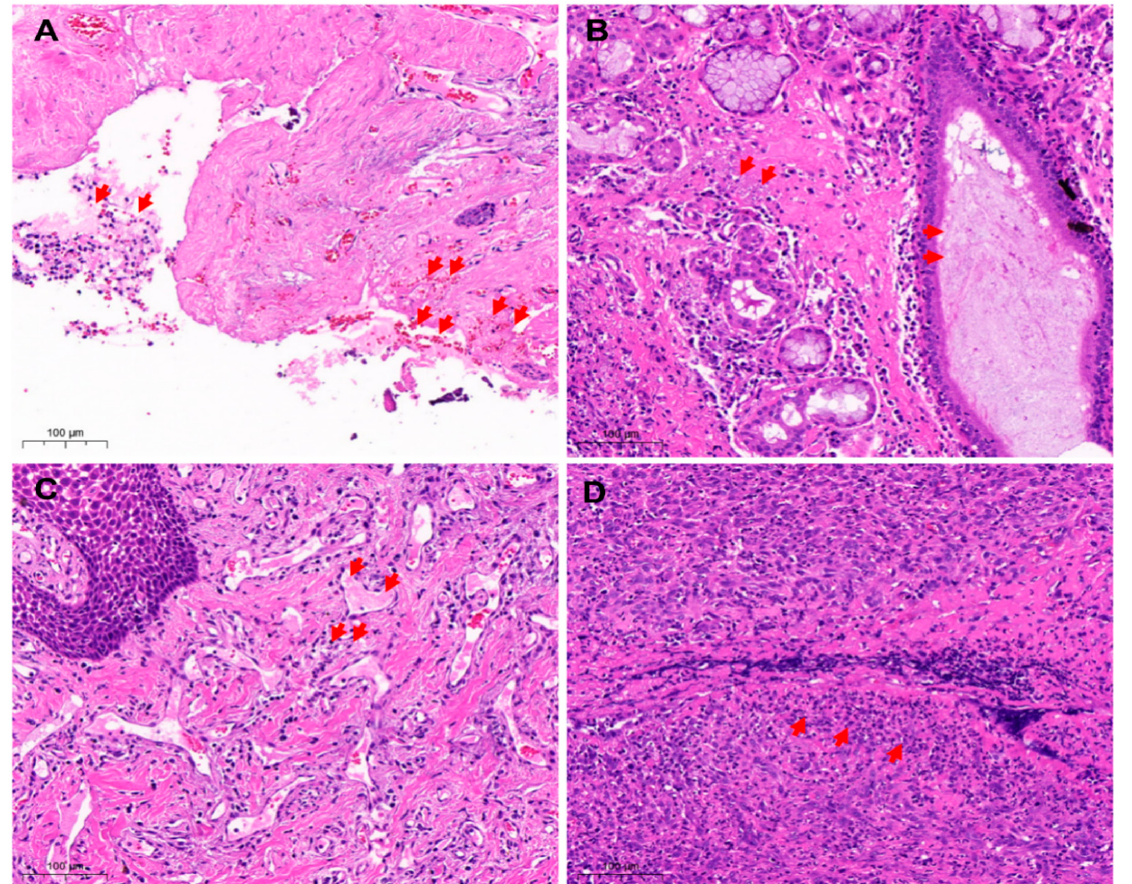
Figure 3. Histopathological analysis of oropharyngeal samples. ( A ) Loss of oral mucosa (H&E 20x). The gingival mucosa epithelial cells fell off, and the lamina propria was congested and hemorrhaged with many inflammatory cells that targeted endothelial cells (arrows) and contributed to the developmental abnormalities of structure and function. ( B ) The mucosal epithelial cells were necrotic and exfoliated (H&E 20×). The inflammatory cells were extensively infiltrated and necrotic. The acinar epithelial cells degenerated, filling the acinar cavity with mucus (arrows). ( C ) Necrosis of cells in the lamina propria of gums (H&E 20×). The lamina propria was hyperemic, thrombus appeared in the blood vessels with the extensive infiltration of inflammatory cells (arrows). In addition, nuclear condensation, nuclear fragmentation, and nuclear lysis were noticed. ( D ) Oral tissue cell necrosis (H&E 20×). Bleeding, congestion, infiltration of inflammatory cells (arrows), and necrosis of the inherent layer of the gums. Red arrows mark hemorrhage, shedding of inflammatory cells, thrombosis, and necrosis of inflammatory cells. The comparison of nucleotide (nt) and AA homology between 17 FCV isolates in this study and 34 reference strains showed that the nt and AA homology between the isolates and the reference strains were 67.3–84.4% and 90–96.7%, nt and AA homology between isolates were 68.3–98.4% and 90.9–99.2%, respectively (Table 3). Moreover, the similarity between F9 and 255 strains were AA: 93% and nt: 73.8%,